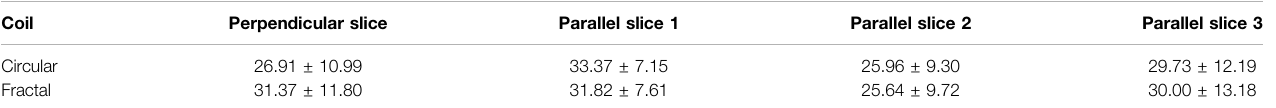
TABLE 3 | The mean and standard deviation of each of the measured B 1+ maps shown in Figure 5 , given in μ T over the FOV shown in the map. The three parallel slices are listed in order of depth from the coil: 15, 25, and 35 mm respectively.